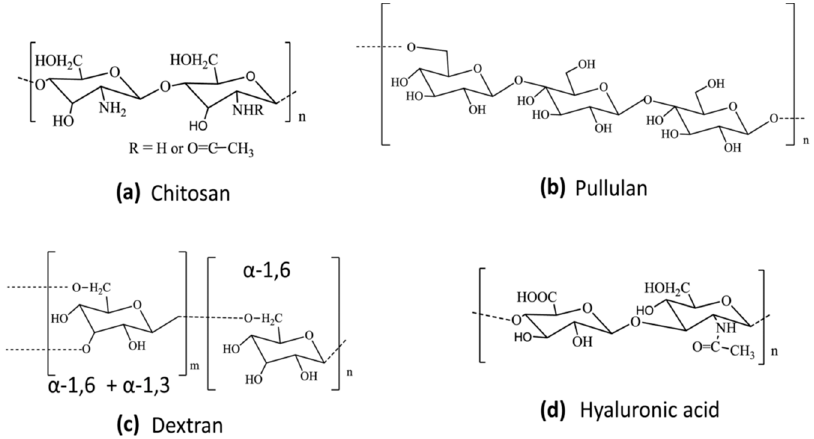
Figure 8. Chemical structures of commonly used natural polymers for gene delivery. Chitosan ( a ) is a linear amino polysaccharide comprising randomly distributed β (1,4)-linked D-glucosamine and N-acetyl-D-glucosamine units. Pullulan ( b ) is a water-soluble linear polysaccharide, with α -1,4-glucopyranose and-1,6-glucopyranose units. Dextran ( c ) is a carbohydrate polymer composed predominantly of α -1,6-linked glucopyranose units with a low degree of 1,3-branching. Hyaluronic acid (HA) ( d ) is an anionic polysaccharide, a glycosaminoglycan (GAG) composed of repeating polymeric disaccharides of D-glucuronic acid and N-acetyl-D-glucosamine linked by a glucuronidic β (1 → 3) bond.